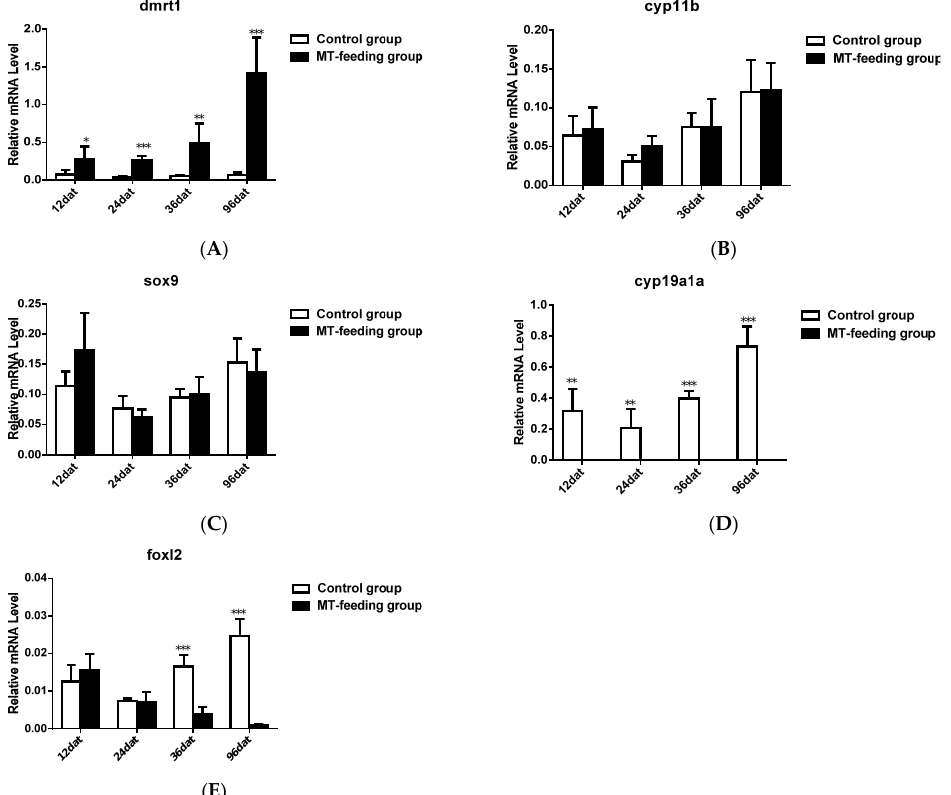
Figure 2. Expression profiles of key genes known to be involved in sex differentiation during MT-feeding induced sex reversal. ( A – C ), Gene expression of male-related genes dmrt1 ( A ), sox9 ( B ) and cyp11b ( C ) during MT-induced sex reversal ( D , E ), Gene expression of female-related genes cyp19a1a ( D ) and foxl2 ( E ) during MT induced sex reversal. β -actin was used as the internal control. Data are expressed as the mean ± SD for three replicates obtained from five fish samples. *, ** and *** represent significant difference at p < 0.05, p < 0.01 and p < 0.001 between the control group and the MT-feeding group.